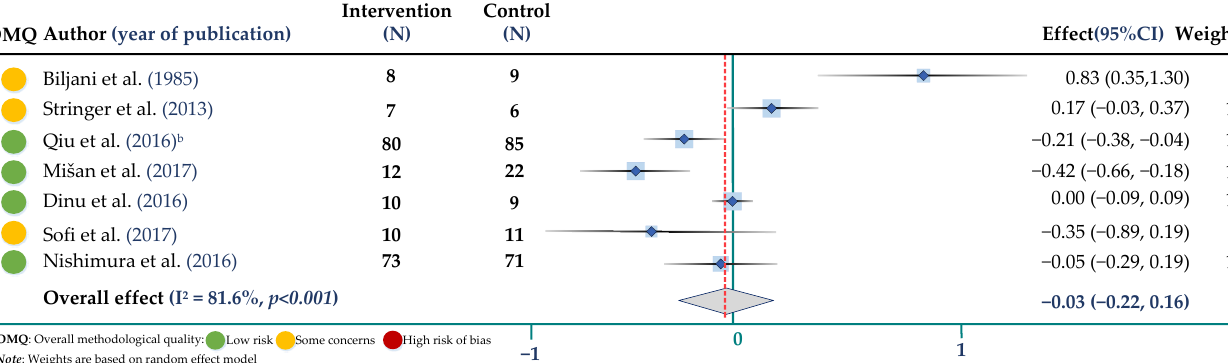
High risk of bias OMQ : Overall methodological quality: Figure 5. Meta-analysis of buckwheat supplementation and LDL cholesterol. b indicates the Qiu study according to Table 2 [17,18,22,25,28,31,32]. All studies were based primarily on interventions using BW flour, except the study by Archimowicz-Cyrylowska et al. (1996), which used non-grain component of BW in the form of herbal supplementation. In a posteriori analysis, we excluded this study from the meta-analyses, but this did not materially affect our results on blood lipids (supplemen- tary Figures S8 – S10). Only a few studies (2/7) had mean values of LDL cholesterol at base- line out of the normal range in the intervention arm (Table S5). Leave-one-out sensitivity analysis in general showed consistent results with the main findings, except for the meta- analysis on TC and HDL-C for which removing the study by Stringer et al. (WMD = −0 .20 mmol/L, 95% CI: −0 .33; −0.07) and Mišan et al. 2017 (WM D = −0 .05 mmol/L, 95% CI: −0 .10;